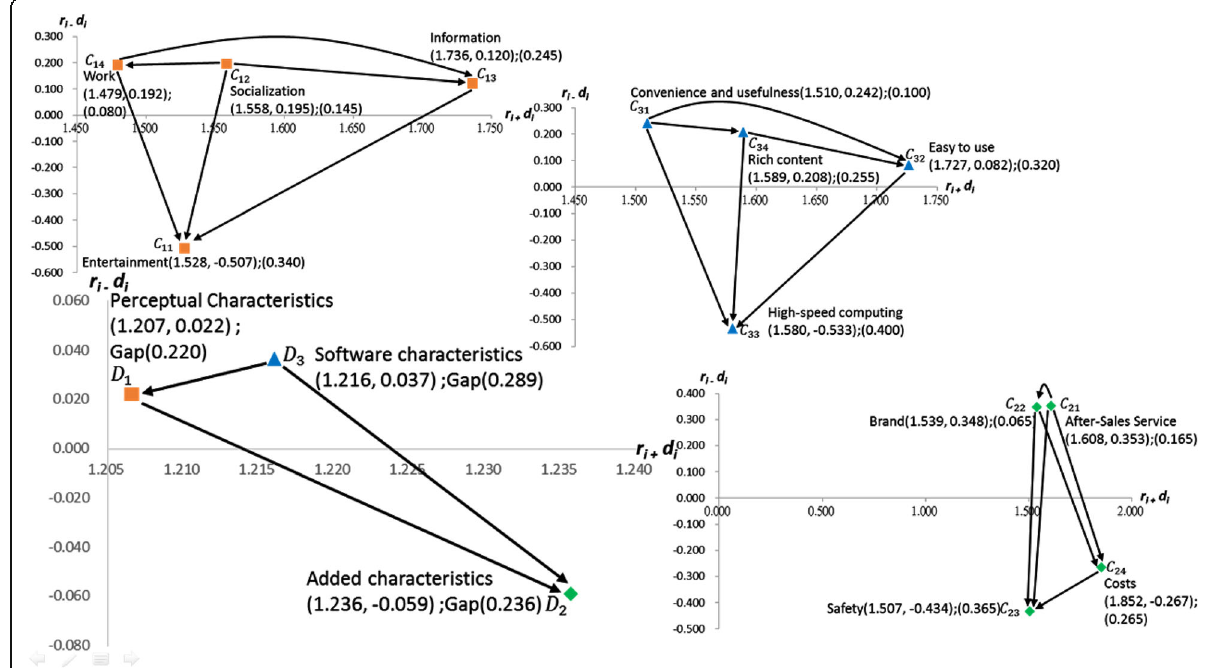
Fig. 1 Network diagrams representing effects of decision-making factors regarding cloud computing service applications